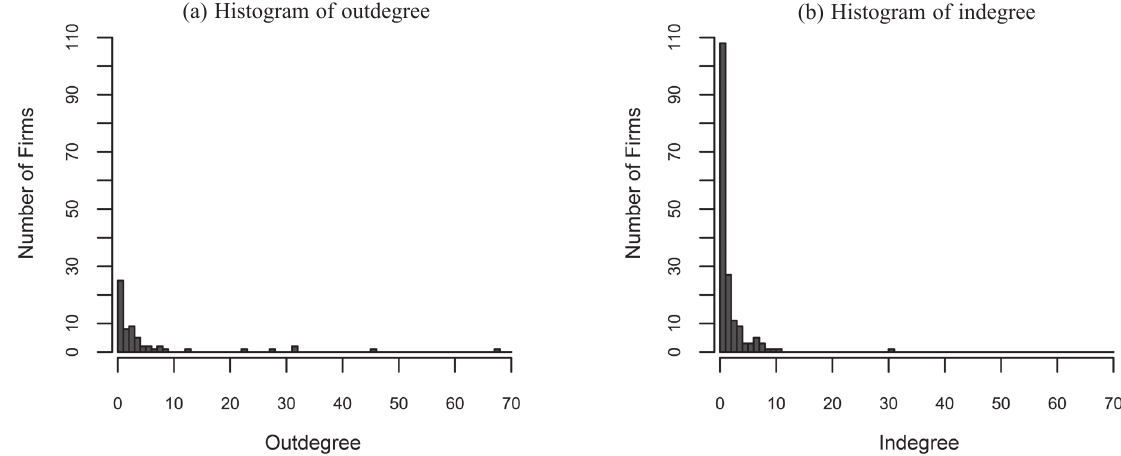
Fig. 4. Outdegree distribution (a), indegree distribution